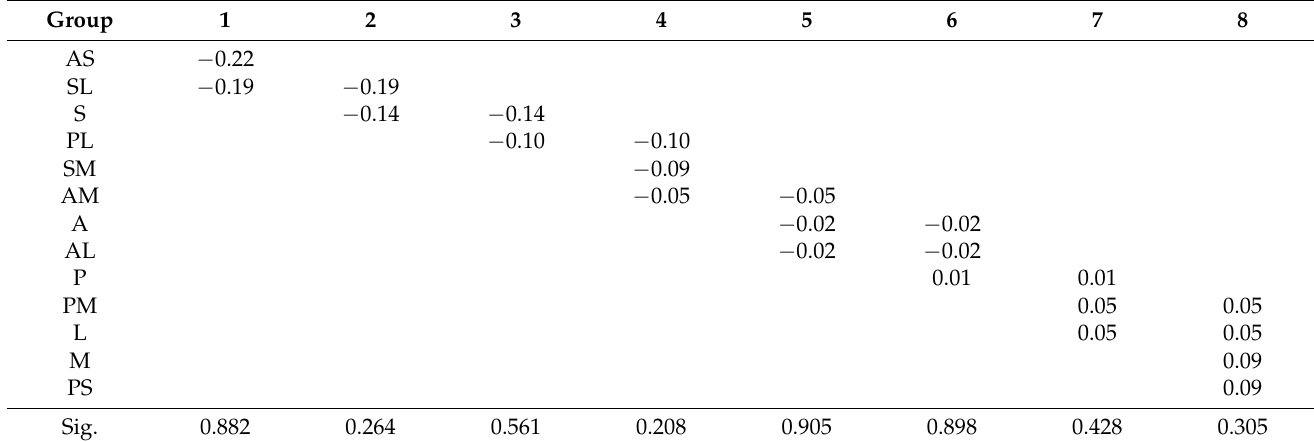
Table 3. Scheffe post hoc comparisons of condylar surface changes between T1 and T2 group *.